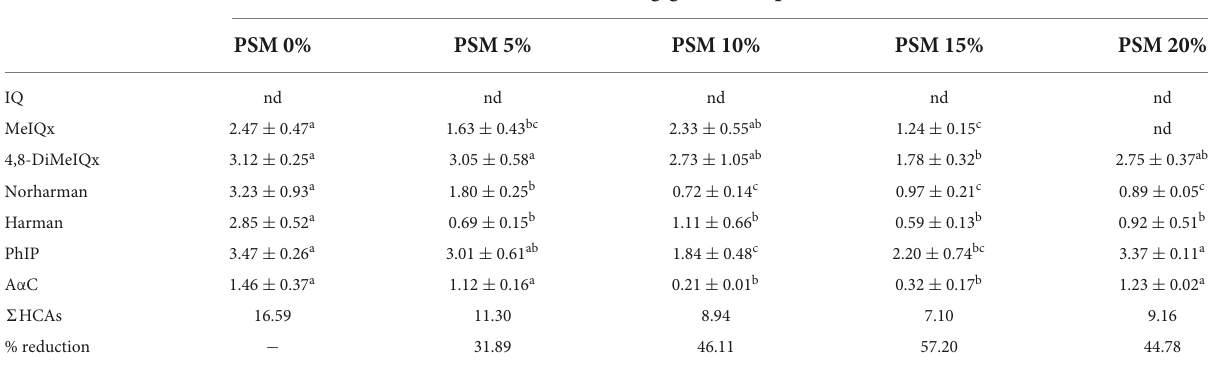
TABLE 5 Contents of different HCAs in pan-fried chicken patties incorporated with various levels of Perilla seed meal